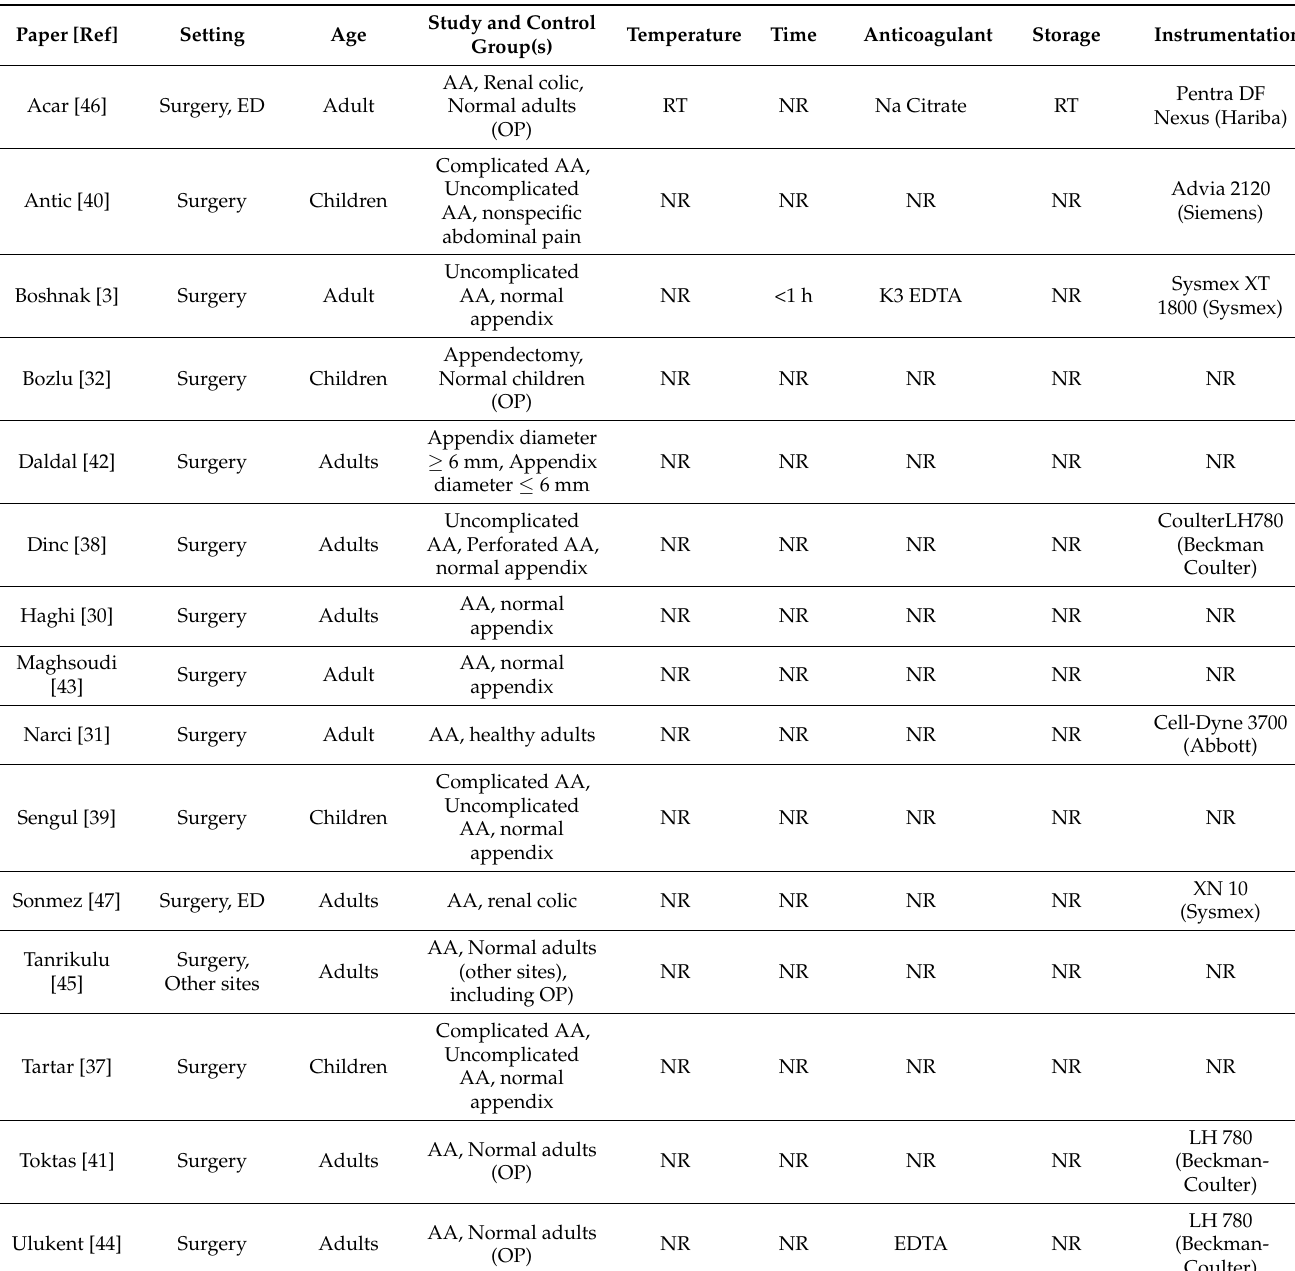
Table 1. Summary of reporting of preanalytical and analytical phase data from the studies used by Anand et al.